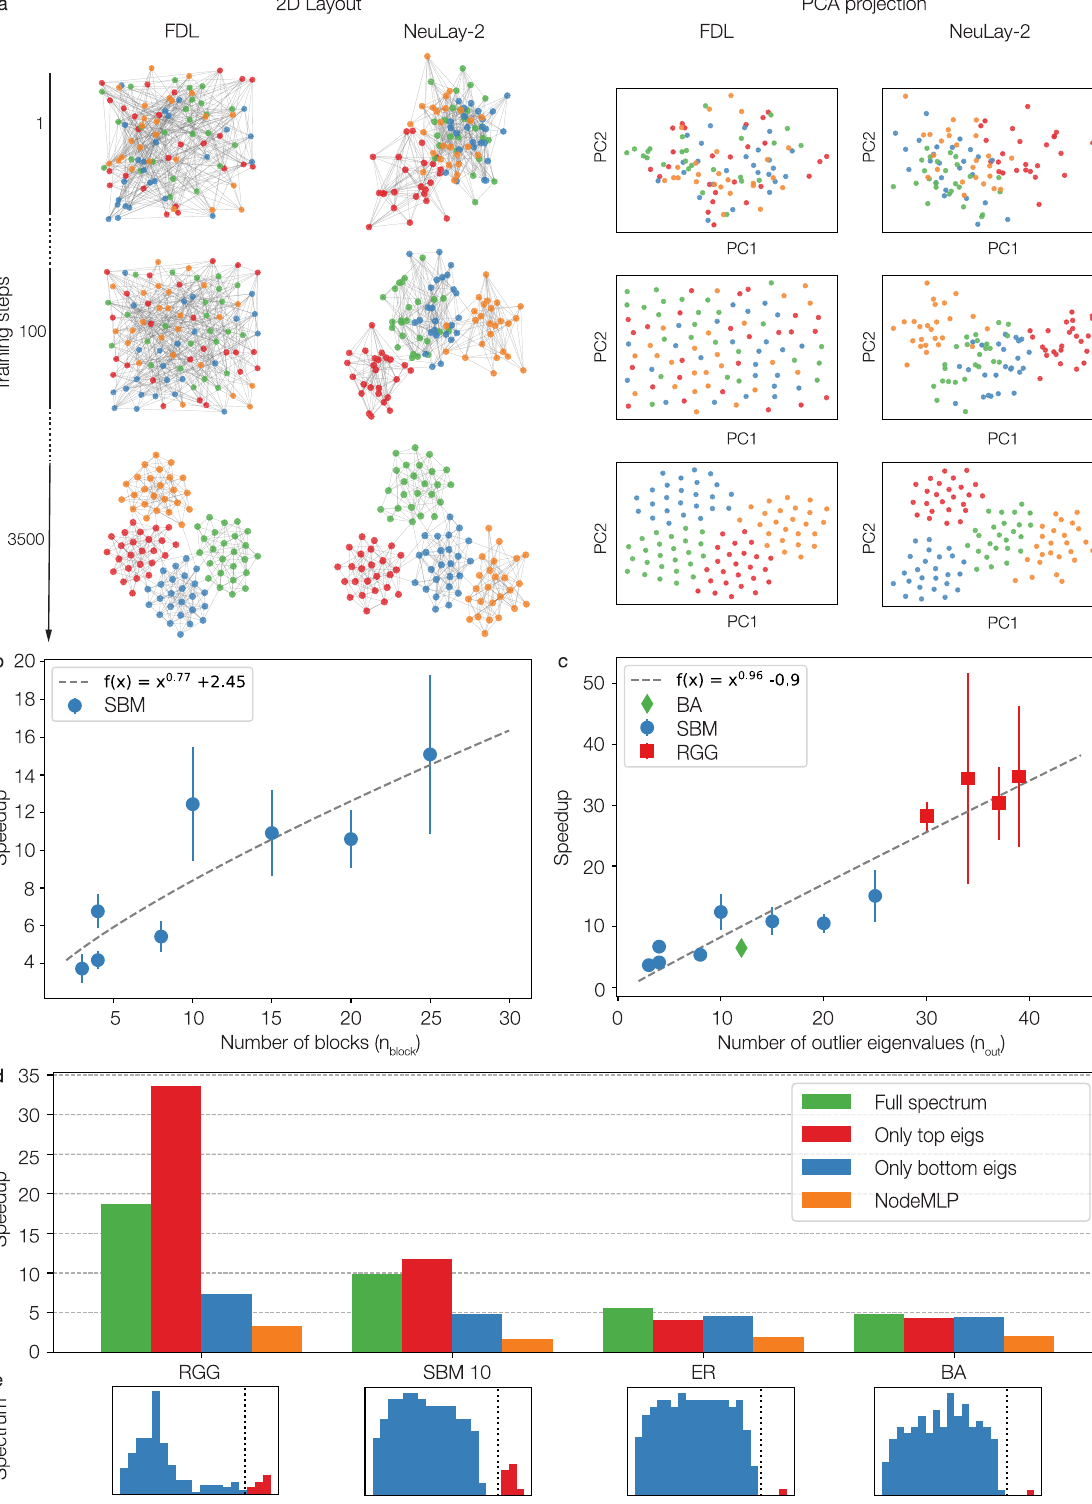
Fig. 2 | The role of leading eigenvalues in network layout. a Comparing the training steps of FDL (left column) and NeuLay-2 (right column) on a SBM graph with 100 nodes and four 25 node blocks. The PCA projection, showing in the right two columns, iscolored for the blocks in the graphs. Asthe panels show, NeuLay-2 separatestheblocksearly,incontrastwithFDLthat fi ndstheblocksonlyatthevery end. b Speedup inthe functionof thenumber of blocks. c Speedup inthe function